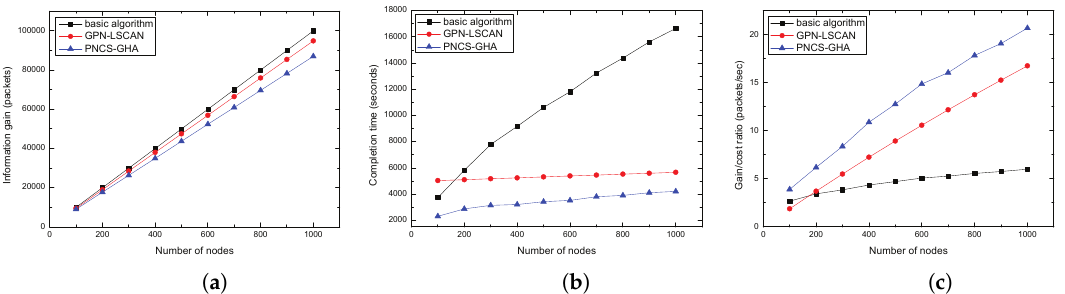
Figure 9. ( a ) Average information gain VS n ; ( b ) Average completion time VS n ; ( c ) Average gain to cost ratio VS n .